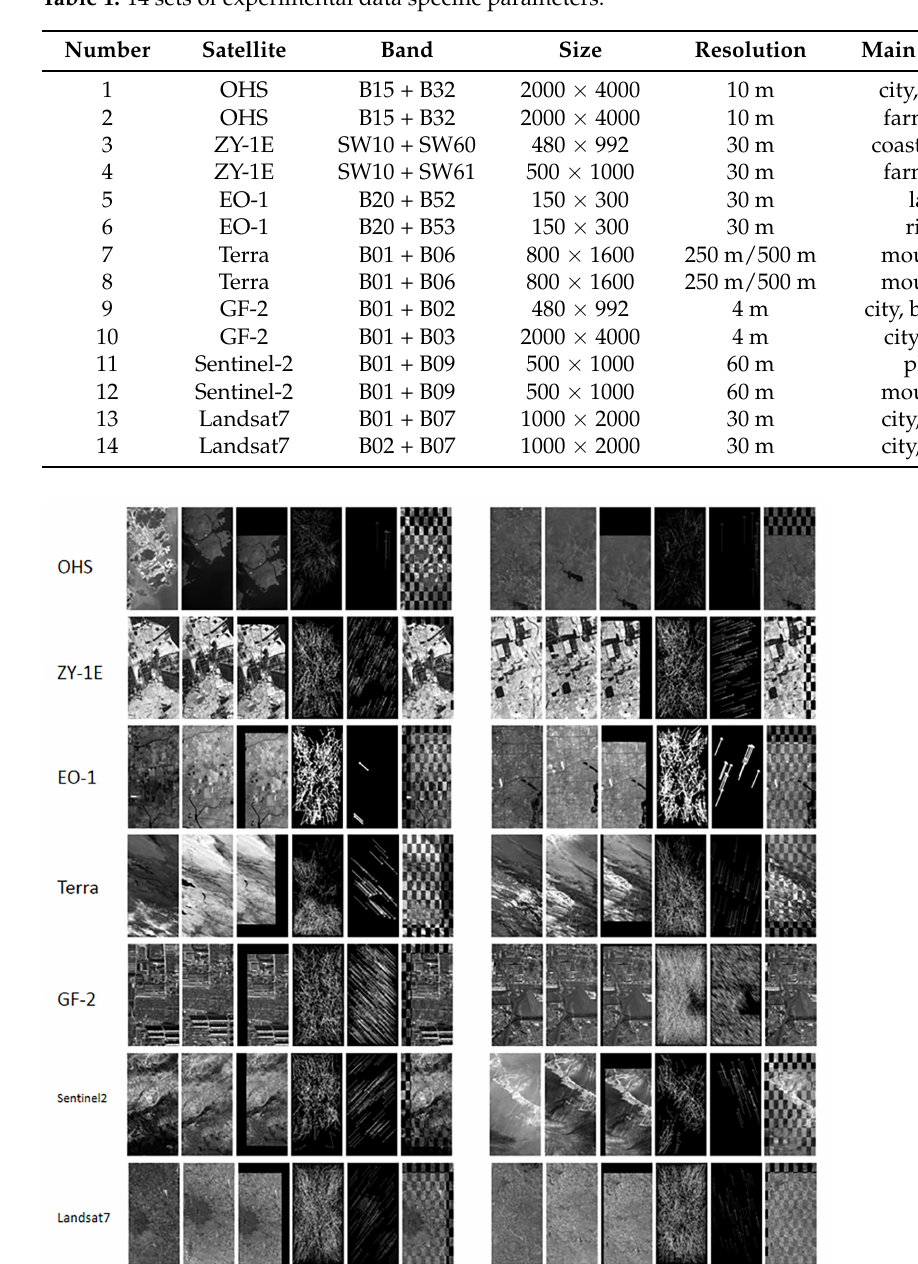
Table 1. 14 sets of experimental data specific parameters.